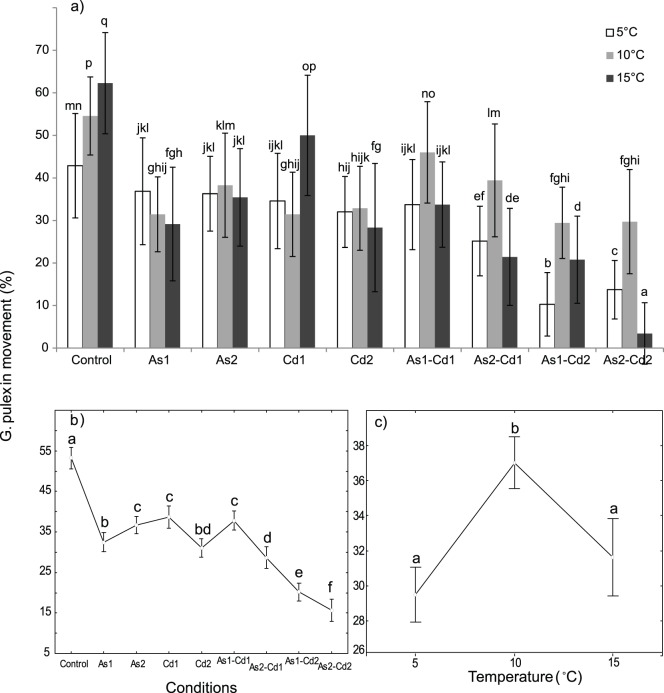
Mean mobility of Gammarus pulex (in %) exposed to different conditions. Mobility obtained for individuals exposed 96 h to different conditions (control, arsenate, cadmium and four binary mixtures) at three temperatures (5-10-15°C). a) Temperature × condition effect: Mean mobility (%) for each tested condition and temperature. Vertical bars represent standard deviations. b) Condition effect: Weighted mean locomotor activity for each tested condition (results for all the tested temperatures were combined). Vertical bars represent 0.95 confidence intervals. c) Temperature effect: Weighted mean locomotor activity for each temperature (results for all the tested conditions were combined). Vertical bars represent 0.95 confidence intervals. Letters (a to q) were used as labels to illustrate significant differences in mean mobility values (two-way ANOVAs + LSD Fisher post hoc tests; at p<0.05 level of significance).